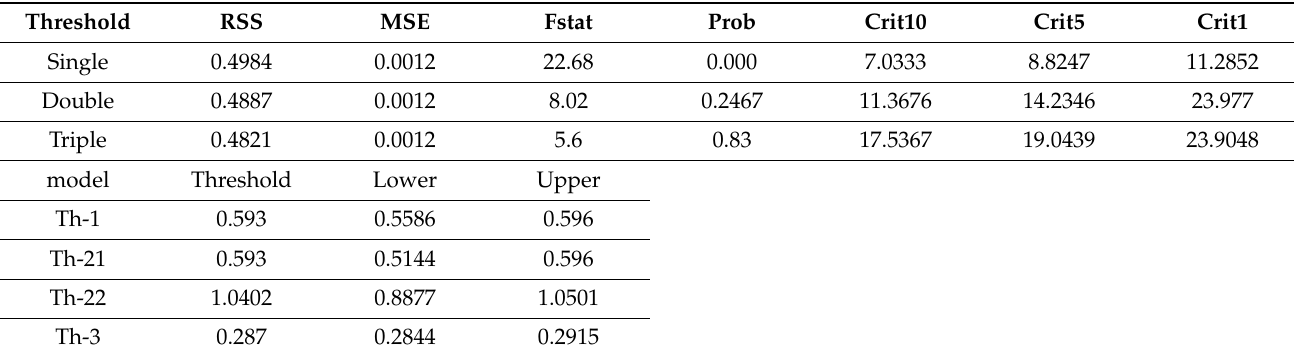
Table 10. Results of testing for the existence of the threshold